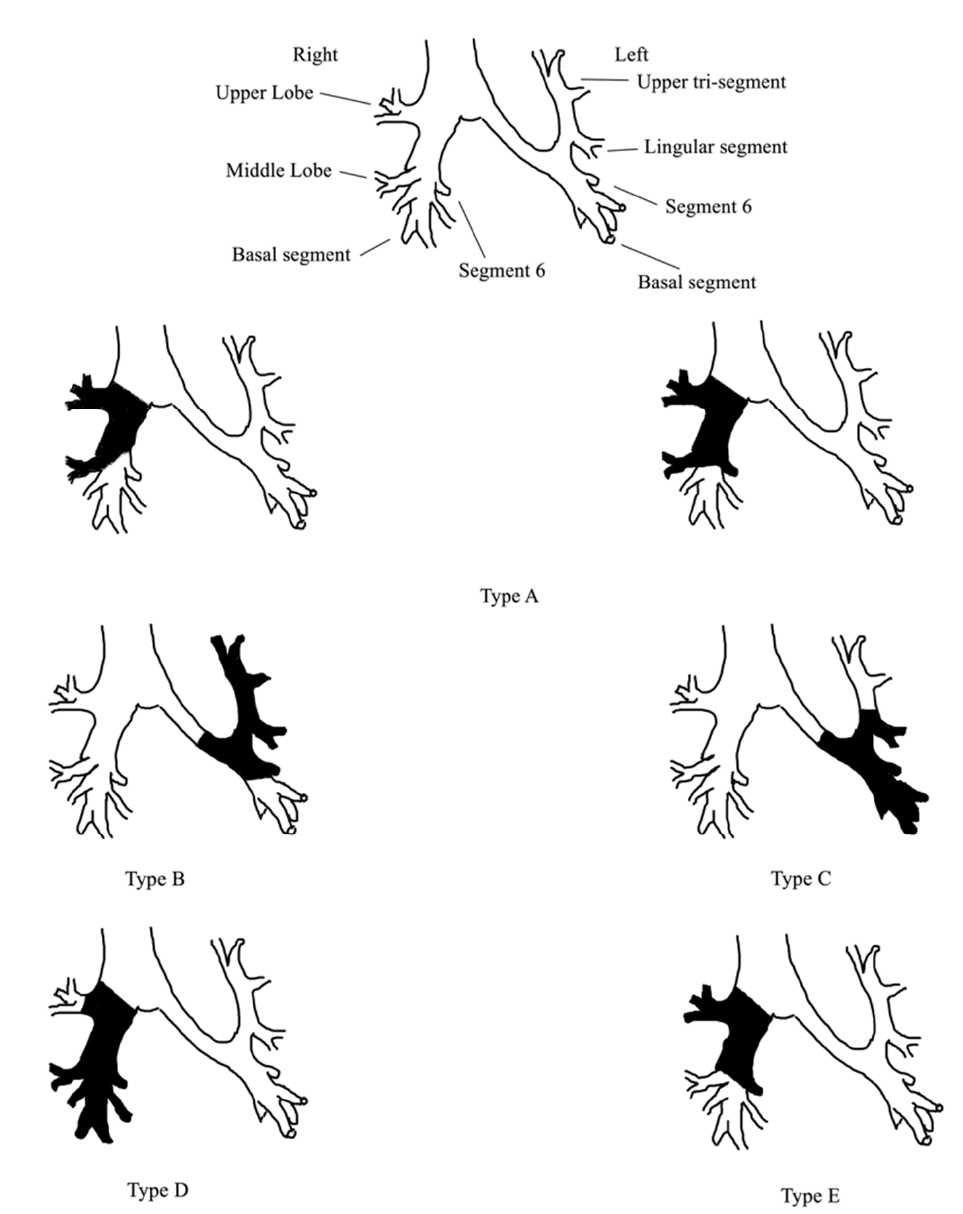
Figure 1. Different extended sleeve lobectomy (ESL) types according to the modified Okada classi- fication.